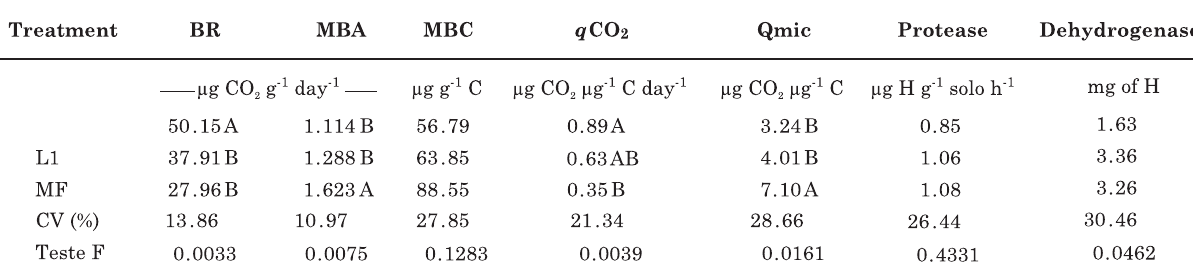
Table 5. Basal respiration (BR), microbial activity (MBA), microbial biomass carbon (MBC), metabolic quotient ( q CO ), microbial quotient (Qmic), and soil enzyme activities of protease and dehydrogenase, 2 at the 0–0.20 m depth layer, in plots treated with sewage sludge at rates of 20 t ha -1 (L2), 10 t ha -1 (L1) and mineral fertilizer